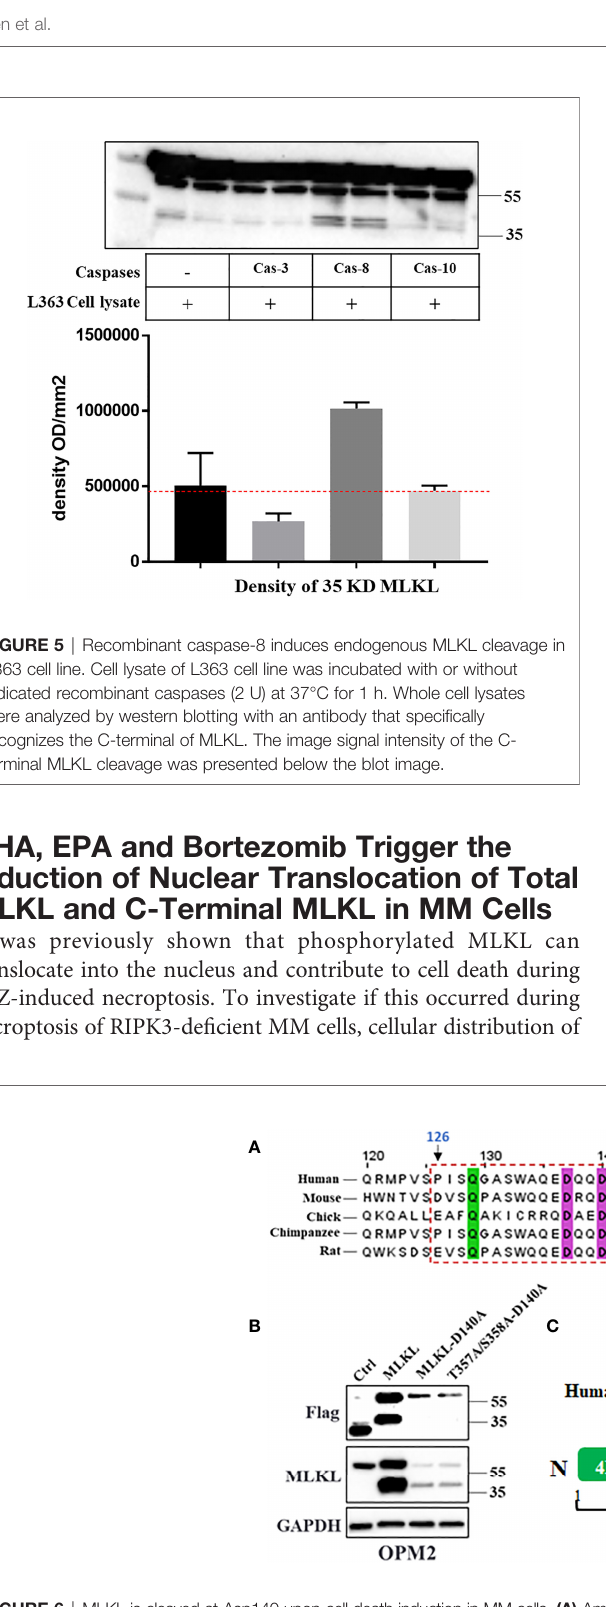
FIGURE 6 | MLKL is cleaved at Asp140 upon cell death induction in MM cells. (A) Amino acid sequences alignment of the fi rst a -helix of MLKL BR domain from multiple species. The conserved residues are highlighted with colored shading and the potential cleavage region (126-153 aa) was indicated in a rectangle with dashed border. (B) OPM2 cells were transfected with 5 µg of vectors encoding C-terminal Flag-MLKL WT , C-terminal Flag-MLKL D140A or C-terminal Flag-MLKL T357A/S358A-D140A . After 18 h, whole cell lysates were subjected to western blotting with antibodies for C-terminus, Flag and GAPDH. (C) Cartoon diagram of MLKL structure and the cleavage by caspases. Human MLKL can be cleaved by activated caspases at Asp140 in the BR that produce a 16 kDa (N-terminus) and a 38 kDa (C-terminus)